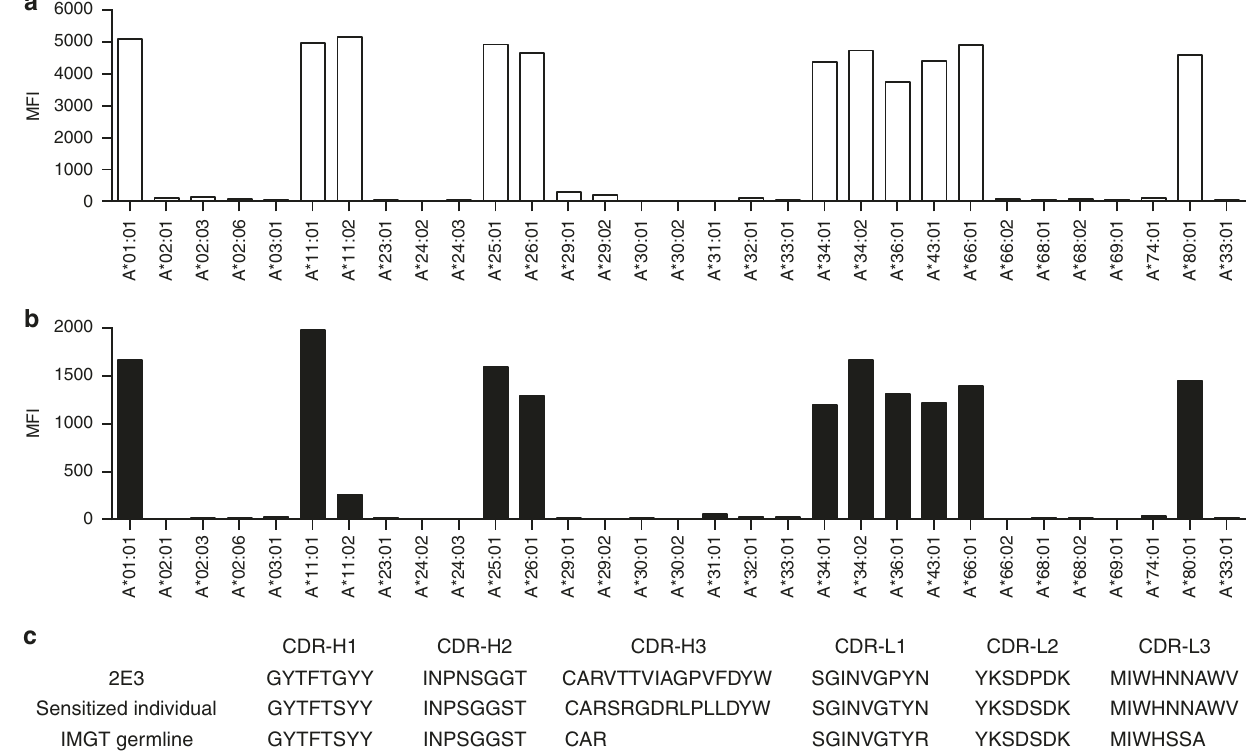
Fig. 1 Allele reactivity and antibody CDR sequence of human monoclonal alloantibody 2E3. a The HLA-A allele reactivity of serum from a renal allotransplant recipient was assessed by OL-SAB. b The allele reactivity of 2E3-IgG1 was assessed at 1 μ g mL − 1 by OL-SAB and overlaps with that of the renal transplant recipient. c Heavy and light chain CDR amino acid sequences were compared between 2E3, a transplant recipient B-cell clone, and the corresponding germline sequences from IMGT ® . The source data underlying Fig. 1a, b are provided as a Source Data fi le. CDR complementarity- determining region, OL-SAB One Lambda LABScreen Single Antigen beads, HLA human leukocyte A high-resolution structural footprint of 2E3 on HLA-A*11:01 . Fig. 3a in the form of an amino acid sequence alignment of The crystal structure of 2E3-Fab interacting with refolded selected HLA Class I alleles. The structural effects of these residue recombinant HLA-A*11:01 monomers was solved by X-ray changes were analyzed. The hydrogen bond between 2E3 light crystallography to 2.4 Å (Fig. 2b, Table 1). As predicted, the chain Asn31 and HLA α chain Asp90 was abrogated when Asp90 resolved epitope includes the eplet de fi ned as amino acid residue was replaced by Ala90 (Fig. 3b). The interaction between 2E3 Asp90 of the HLA α chain (Fig. 2c). This forms a hydrogen bond heavy chain and HLA α chain was interrupted when positively with residue Asn31 and nonbonded contact with Tyr30 of 2E3 ’ s charged Arg14 was replaced by hydrophobic Trp14 ( Fig. 3c). light chain CDR1. 2E3 mainly binds to HLA α chain and partially Four hydrogen bonds between 2E3 heavy chain and HLA α chain interacts with beta-2-microglobulin ( β 2m; see Supplementary were lost when Arg17 was changed to Ser17, which has a shorter Table 2), forming a footprint of 1020.5 Å 2 on the HLA surface. side chain (Fig. 3d). Since no hydrogen bond was involved in the 2E3 heavy chain interaction with Glu19, 2E3 binding was not totally abrogated when negatively charged Glu19 was changed to positively charged Lys19 (Fig. 3e). The interaction between 2E3 heavy chain and HLA α chain was predicted to be affected when negatively charged Asp39 was replaced by hydrophobic Tyr39 (Fig. 3f).